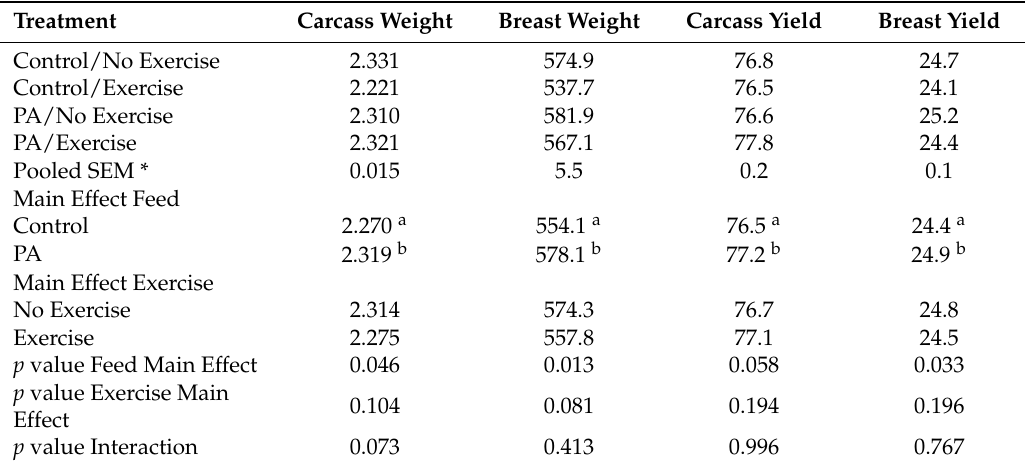
Table 5. Processing data: carcass weight (kg), breast weight (g), carcass Yield (%), and breast yield (%) in Experiment 1.